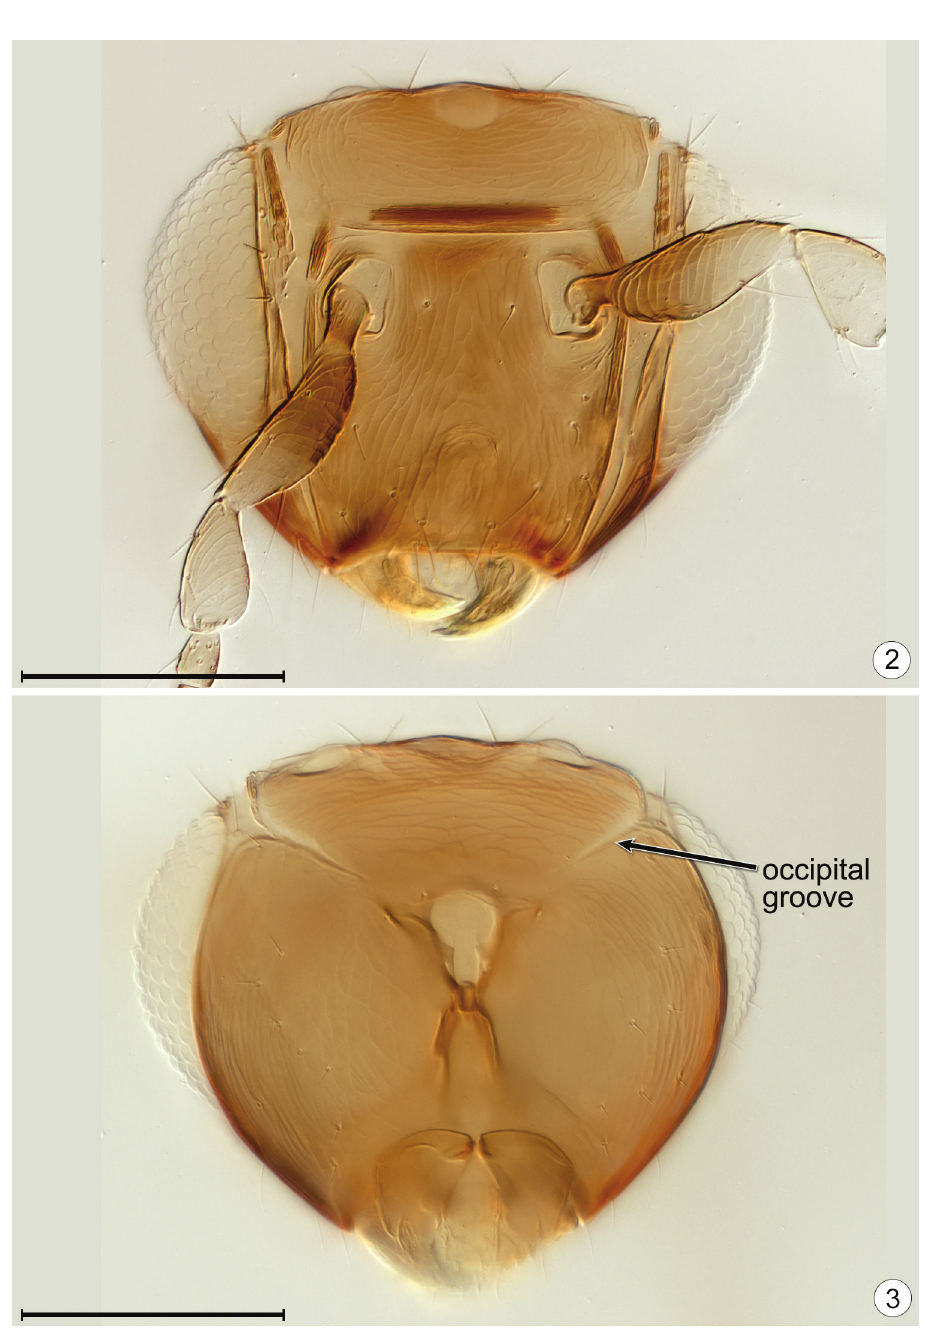
Figures 2, 3. Anaphes brevis , head. 2 anterior 3 posterior. Scale bars: 100